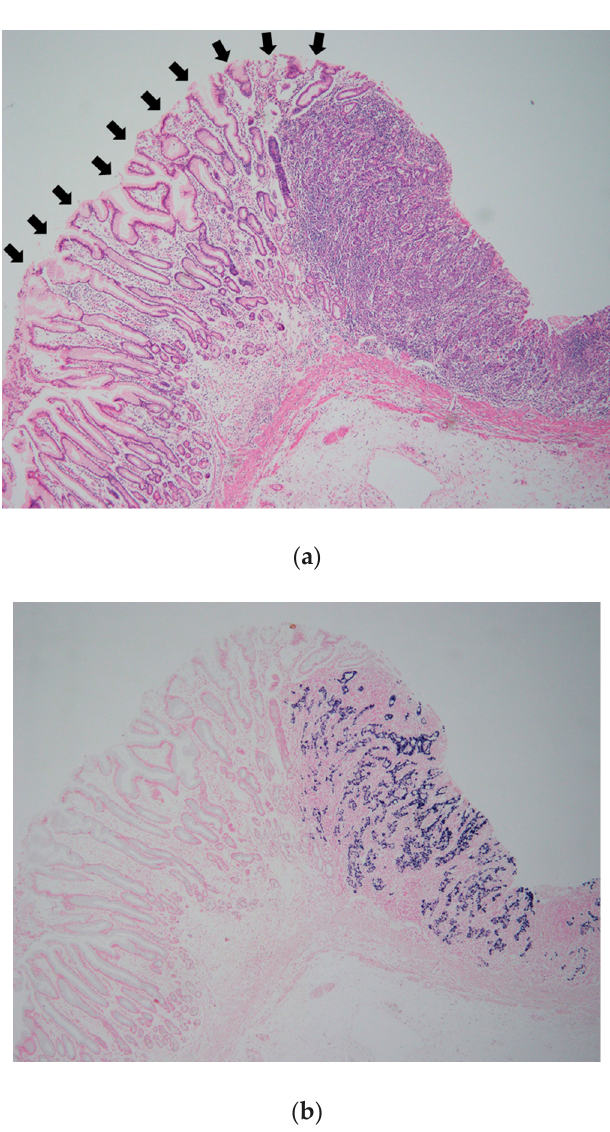
Figure 2. Epstein–Barr virus-associated gastric carcinoma (EBVaGC). ( a ) Moderately differentiated adenocarcinoma is composed of irregular tubules and moderate lymphocytic infiltration. Black arrows indicate non-cancerous epithelium; ( b ) Dark-blue signals of EBV encoded small RNA 1 (EBER-1) are observed in cancerous area. Epithelial cells in the non-cancerous mucosa indicated by black arrows in ( a ) are EBER-1 negative. Magnification ( a ) and ( b ) ( ×